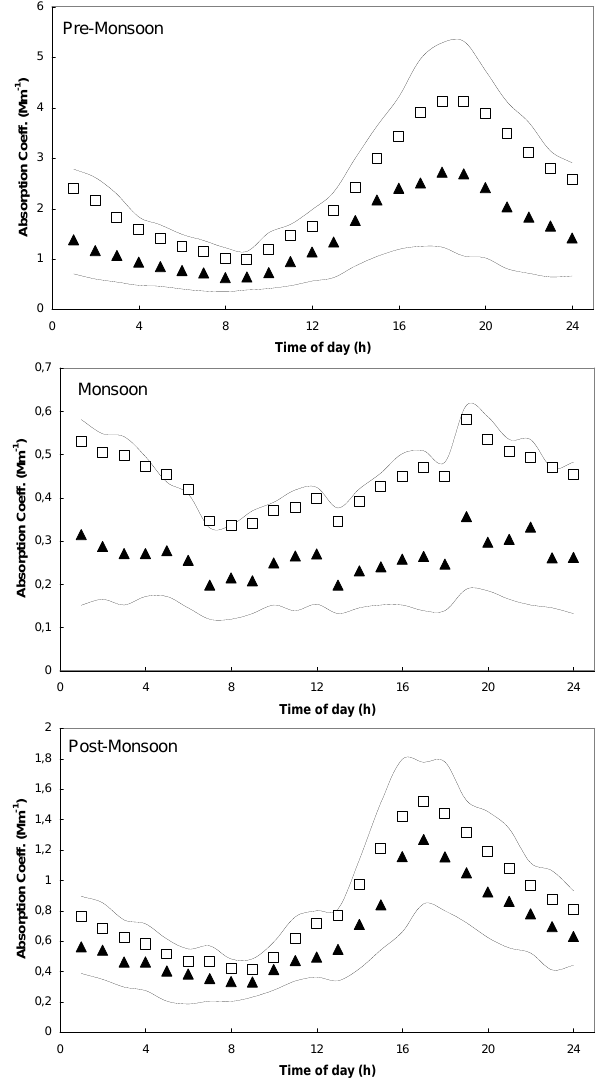
Fig. 3. Diurnal variability of hourly averaged (square) and median (triangle) absorption coefficient values at NCO-P for pre-monsoon, monsoon and post-monsoon periods. Dashed lines represent 25 and 75-percentile,